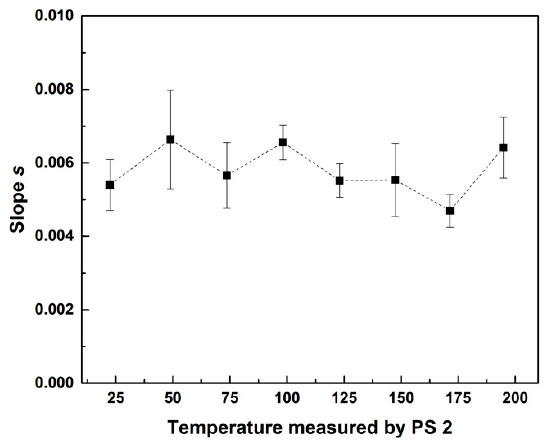
Figure 6. Average drift slope s as function of temperature.